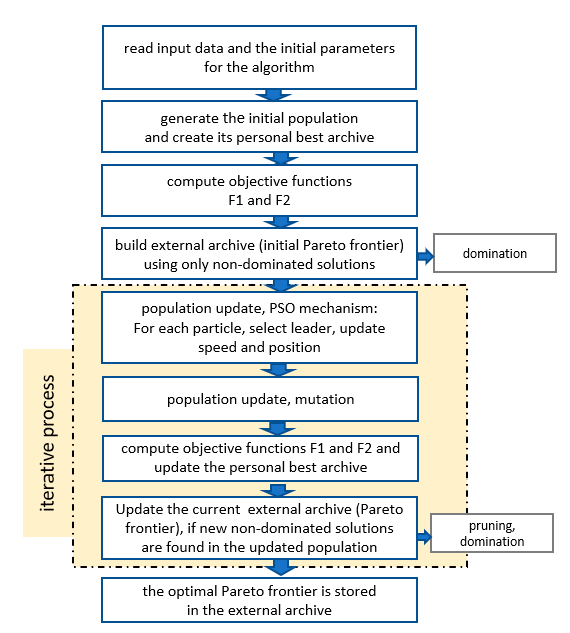
Figure 1. The flowchart of the multi-objective particle swarm optimization (MOPSO) algorithm.